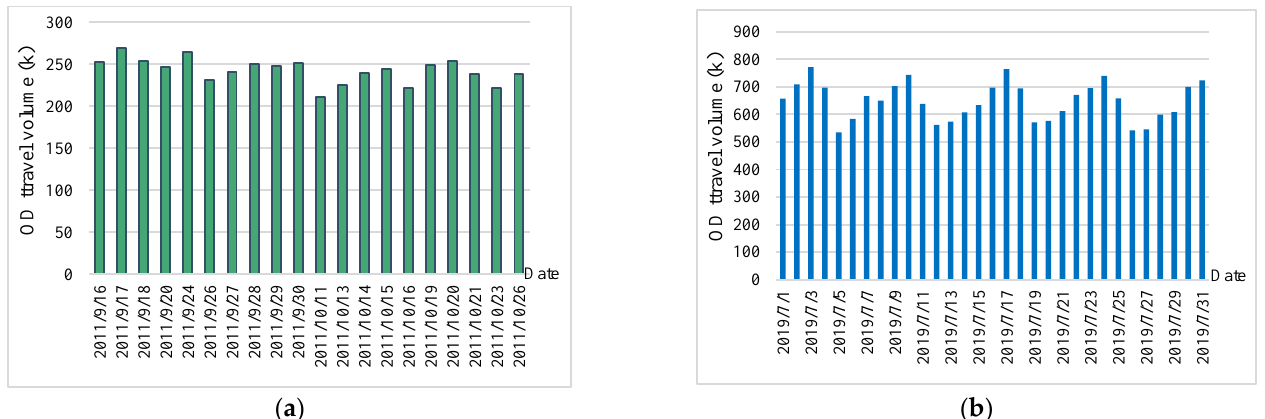
Figure 5. OD travel volume and distance per week. ( a ) Shenzhen City. ( b ) New York City. Figure 6 shows the hourly characteristics of the OD flow. The 20-day data of Shenzhen exhibit a relatively similar general hourly distribution pattern (Figure 6a): the travel activities gradually decrease from 0 to 6 in the early morning and increase rapidly from 6 to 9 during the morning peak hours. No obvious night peak pattern is observed. There is no clear difference between weekdays and weekends. Only one sudden drop in OD trips is observed at approximately 18:00 on 30 September, which is mainly caused by the night peak congestion before the 7-day holiday of National Day of China. Compared with Shenzhen, the hourly distribution of NYC exhibits two different types of hourly patterns (Figure 6b), which correspond to the weekday pattern and weekend pattern, respectively (Figure 7b).